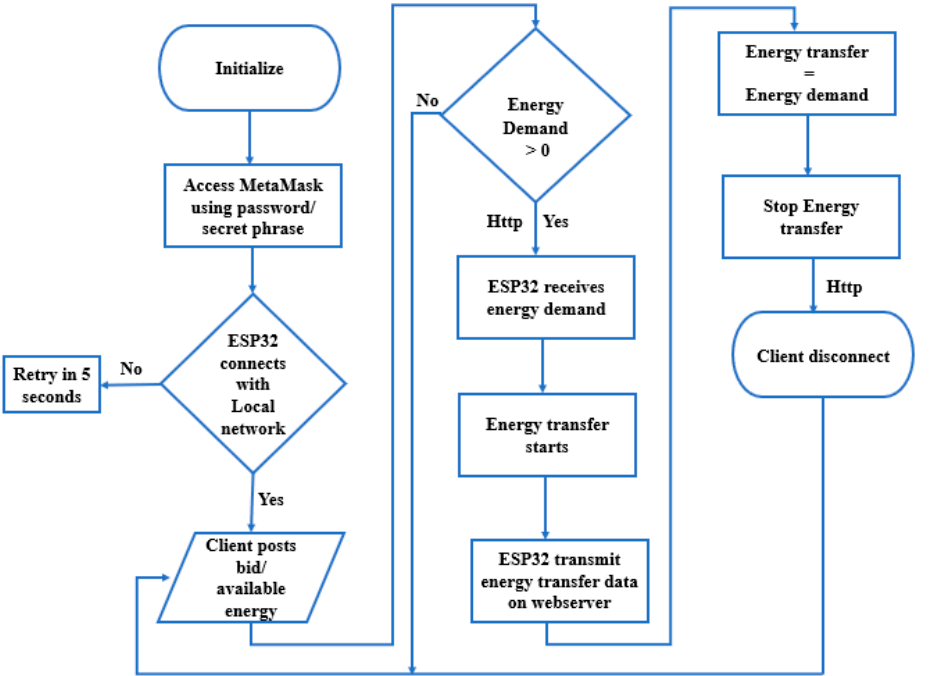
Figure 10. Flow chart of the proposed P2P energy trading system .